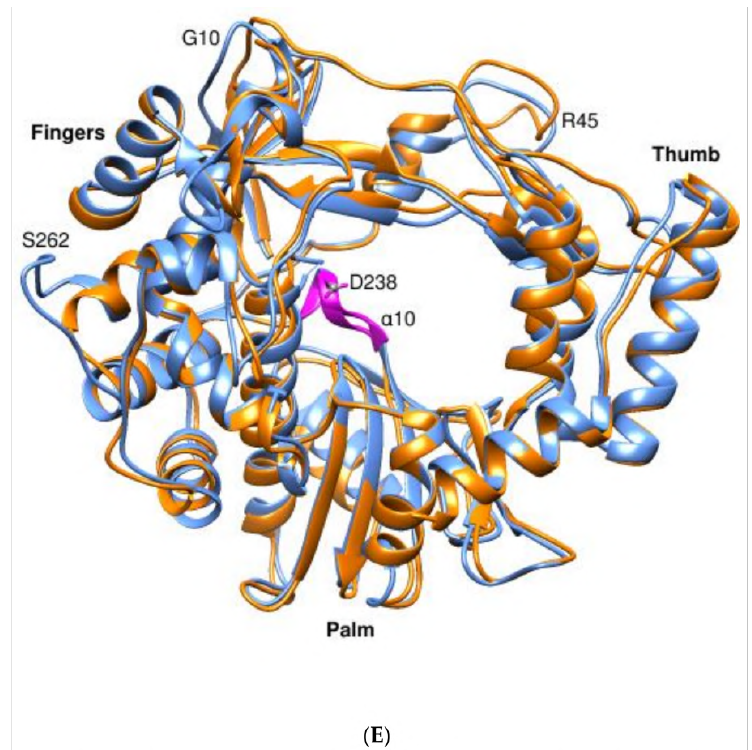
Figure 6. The contributions of the NTDs in replication and transcription. ( A ) NTDs of the peri- bunyaviral polymerases. The transcription initiation stage of the LACV polymerase (PDB 7ORL). The endonuclease and the CBD are shown in sea green and light orange colors, respectively. The other domains from N- to C-terminus are depicted in rainbow colors and represented as ribbons. The tem- plate and the product RNA are shown in yellow and gray colors, respectively. The domains at the amino terminus are involved in cap-snatching. ( B ) NTDs of the Flu polymerases. The structure of FluA RdRP (PDB 6EAJ, light gray) with the bound physiological RNA primer (maroon spheres) su- perposed on the apo state of FluB RdRP (PDB 5EPI, dark gray) with bound 5 (cid:48) cRNA (Tan). The CBDs (320-489) of FluA and FluB are colored in light blue and light green colors, respectively, while the midlink (251-319) regions of the two are indicated in dark blue and dark green colors, respectively. The CBD and the midlink regions have rotated by 60 ◦ and 77 ◦ , respectively, with respect to the corre- sponding domains in the apo state of FluB. ( C ) NTDs of Phenuiviridae RdRPs. The superposed ribbon representation of the L protein of SFTSV (PDB 6XYA) on the L of RVFV (PDB 7EEI). The domains of SFTSV are shown in rainbow colors while the RVFV is shown in gray. The marked displacement of the helix (390-400) in RVFV is obvious. The endonuclease, CBD, b, and lariat domains are missing in the RFVF structure. ( D ) NTDs of the flaviviral RdRPs. The nsp5 of CSFV showing the flexible NTD (1-86), the linker (87-92), and the RdRP domains. The structures of PDB 5Y6R (light blue) and 5YF6 (dark blue) show the NTD in a similar disposition, while those of 6AE7 (green) and 5YF8 (yellow) are flipped by almost 180 ◦ and appear in an extended conformation. ( E ) NTDs of the picornaviral RdRPs. The structures of kobuviral and siciniviral RdRPs. The kobuviral (blue) (PDB 6R1L) and siciniviral (orange) (PDB 6QWT) 3D pol superposed and depicted in ribbon representation showing the position of α 10 that is implicated in the activation of the